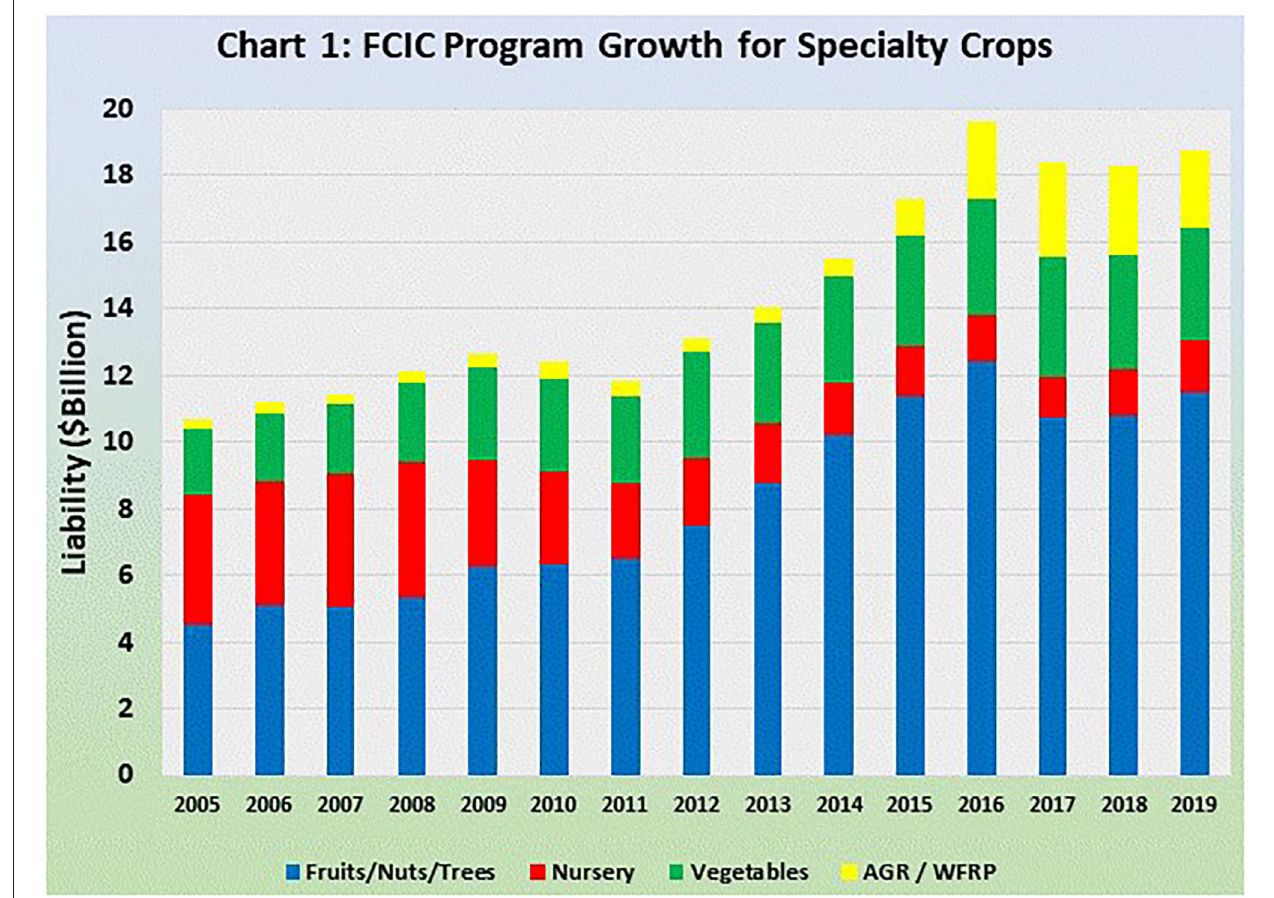
FIGURE 2 | Federal Crop Insurance Coverage Program Growth for specialty crops (Sources USDA -Risk Management Agencvy,